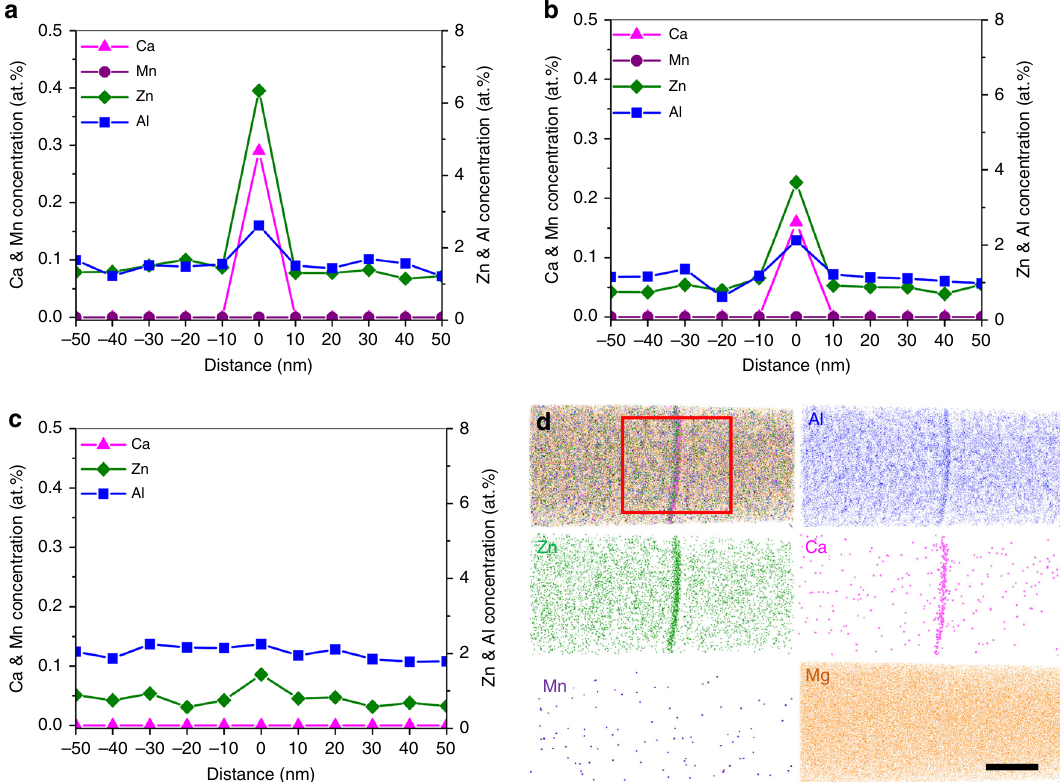
Fig. 3 Segregation of solute elements at grain boundaries. a – c TEM-EDS line scans across grain boundaries of TRC-AZMX3110 ( a ), IC-AZMX3110 ( b ), and IC-AZX310 ( c ). There are signi fi cant amounts of Ca, Zn and Al segregated along grain boundaries of TRC-AZMX3110 alloy, whereas smaller amounts of these solute elements are segregated along grain boundaries of IC-AZMX3110 and IC-AZX310. d Atom Probe Tomography (APT) reconstruction of 45 × 45 × 100 nm 3 volume containing a grain boundary in TRC-AZMX3110. The enrichments of Ca, Zn, and Al along grain boundary are clearly demonstrated (marked by red square). Scale bar corresponds to 20 nm